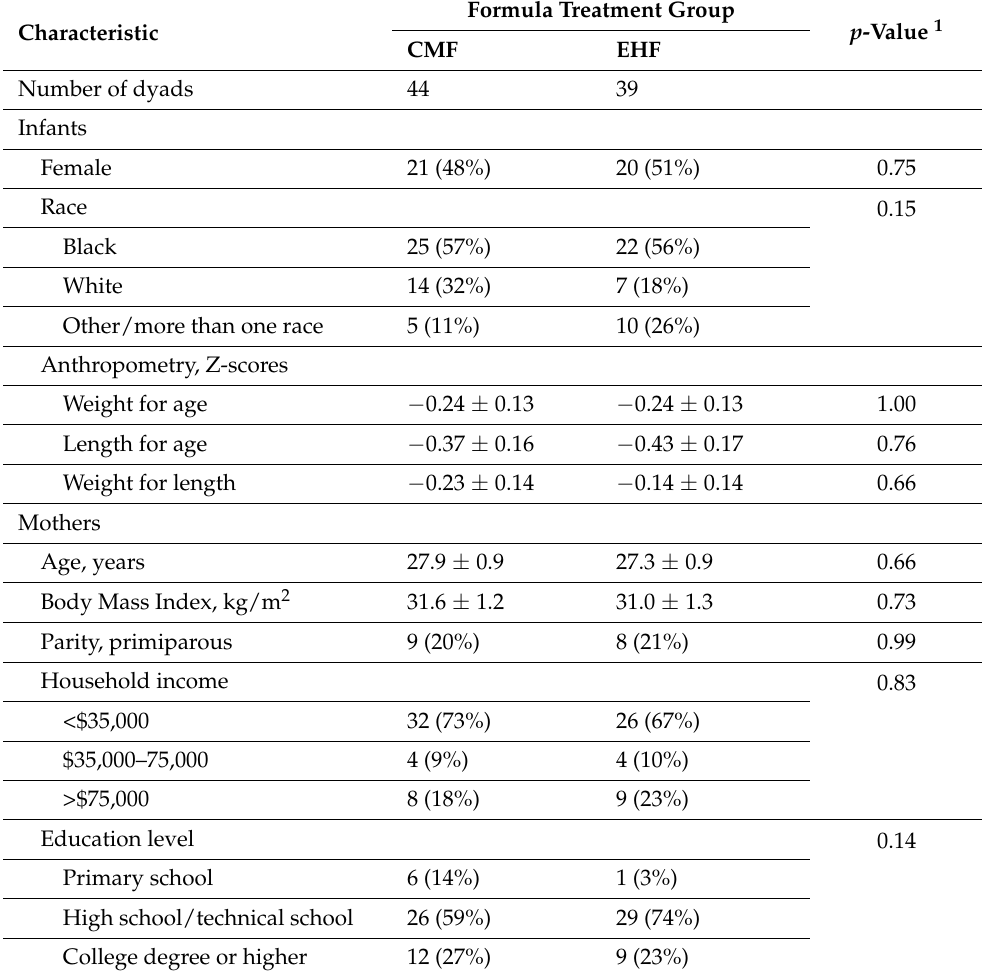
Formula Treatment